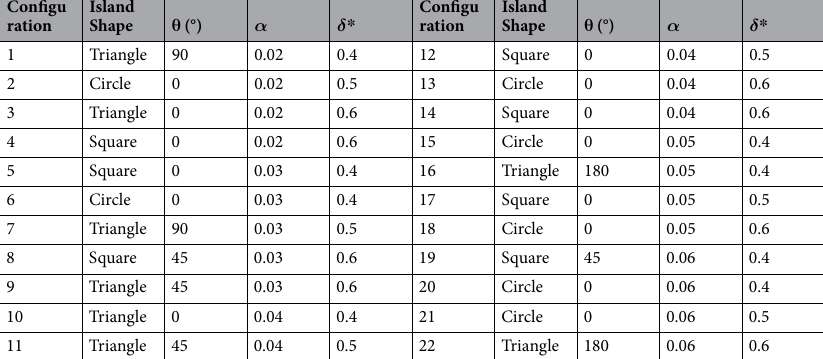
Table 1. Various SDSM configurations and associated design parameters, as constructed using design of experiments (DOE) criteria (see Methods Section below). The control case (SDSM without island) is not listed in this